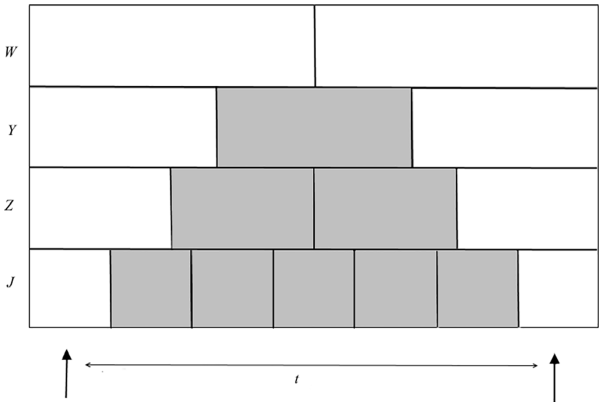
Fig 2. Two stimuli separated by time interval. The speed of integration allows for discrimination between intermittent stimuli. Any cell in each array, W , Y , Z, and J , represents the integration time T int in each arrangement. The arrangement of the Y , Z , and J arrays allows for the detection of two different stimuli. The shadows indicate that the eye perceives darkness during these integration